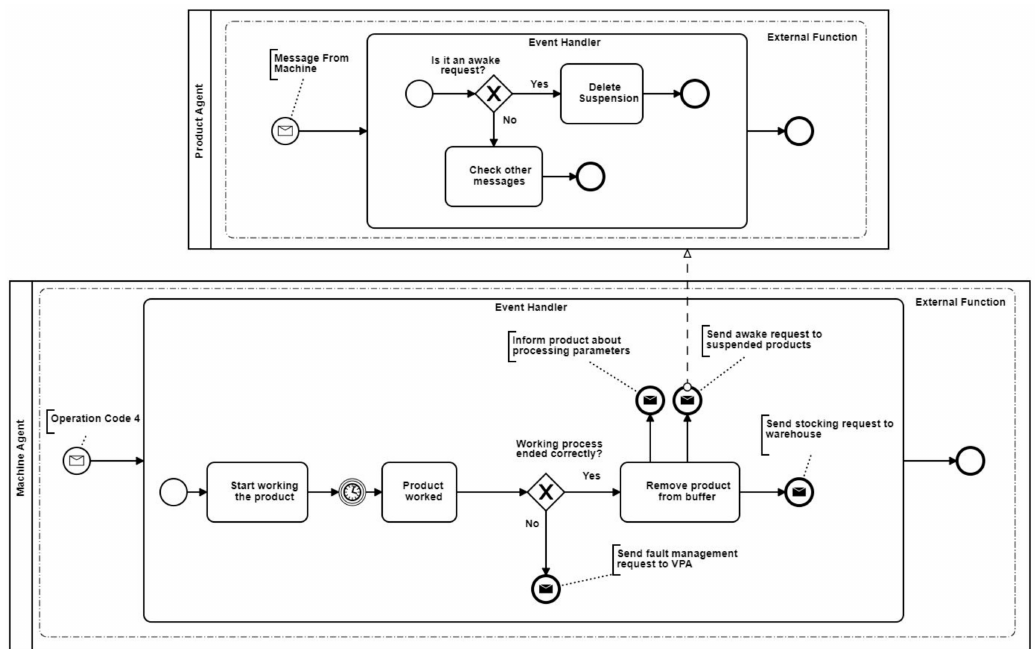
Figure 6. Interaction between Machine Agent and Product Agent when operation 004 occurs.